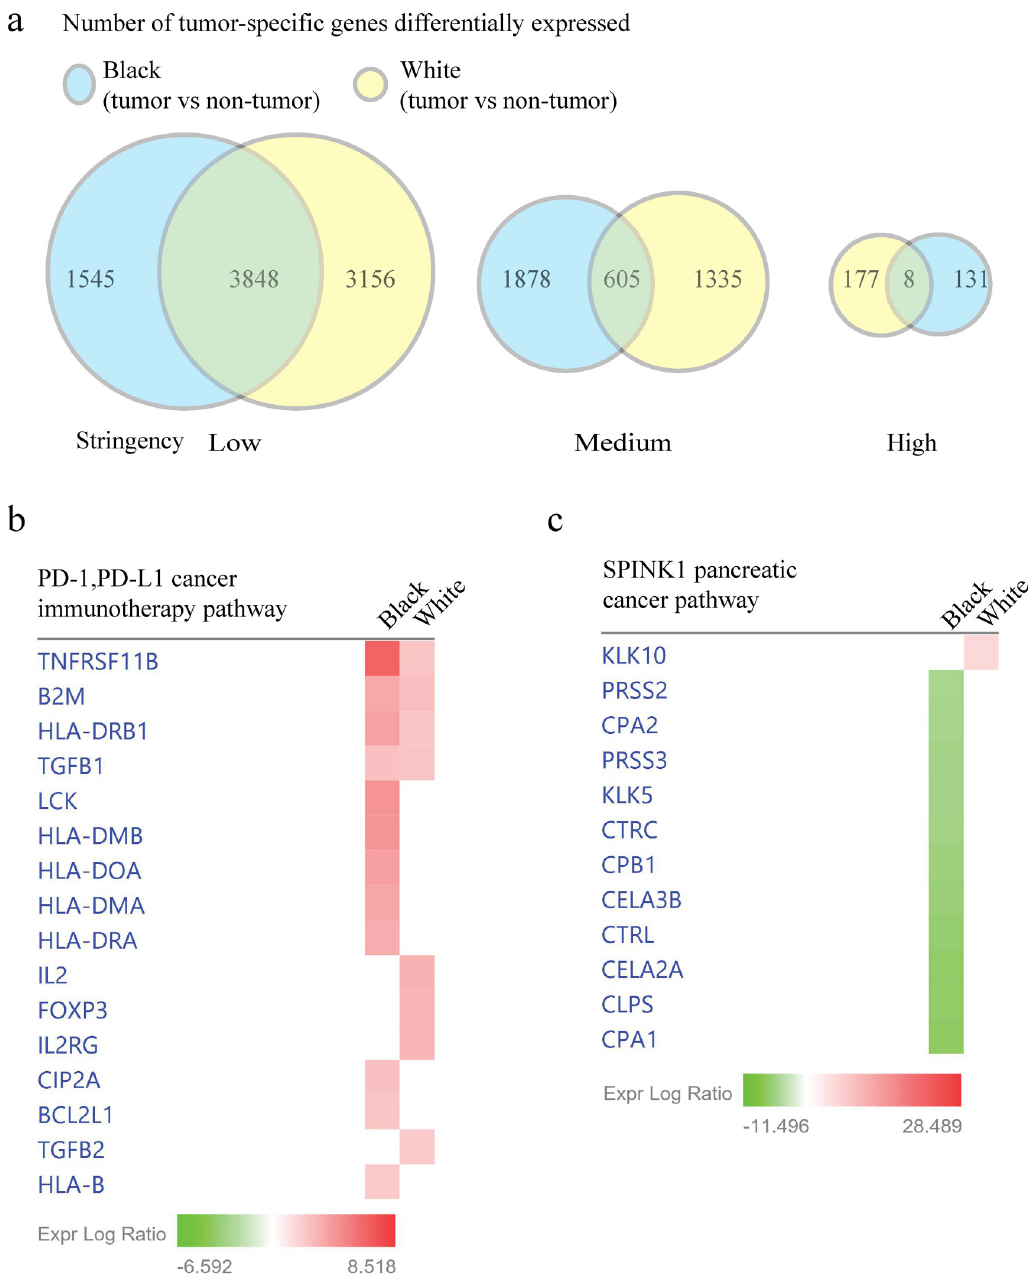
Fig 4. Pancreatic tissue gene expression differences with canonical pathway analyses between Black and White patients. (a) Number of tumor-specific genes with expression differences in pancreatic tumor as compared to non-tumor tissue from Black and White patients. (b) Pancreatic tumor and non-tumor tissue gene expression differences in the PD1, PD-L1 cancer immunotherapy pathway using genes that meet the medium stringency criterion from Black and White patients. (c) Gene expression differences in the SPINK1 pancreatic cancer pathway using genes that meet the high stringency criterion between pancreatic tumor and non-tumor tissue from Black and White patients.